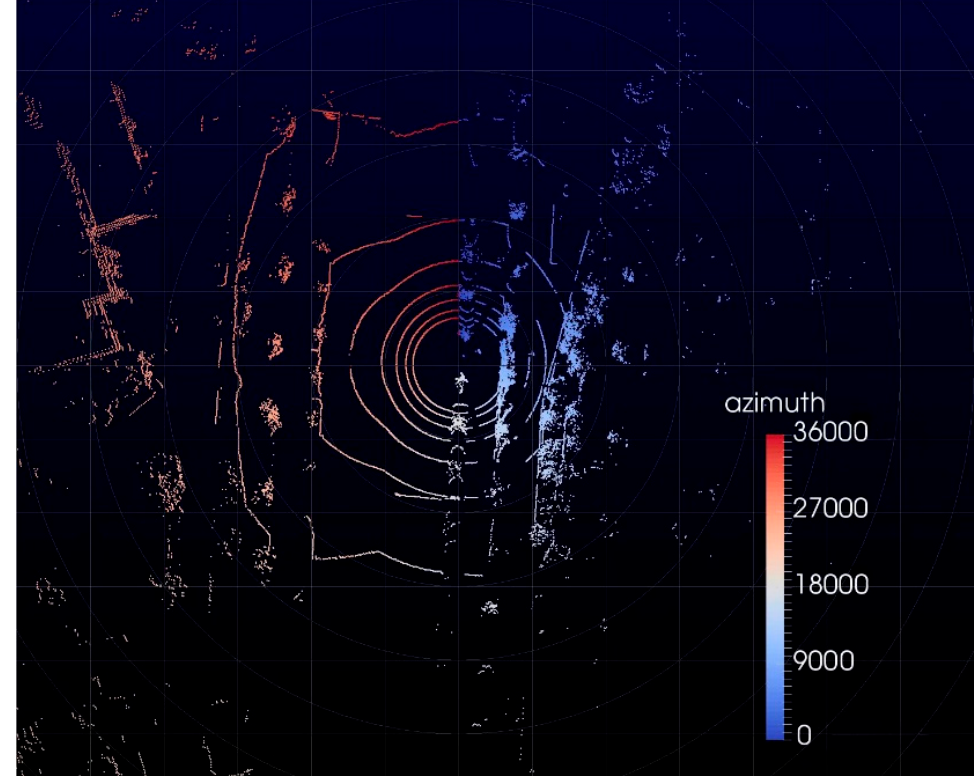
Figure 10. 0° line